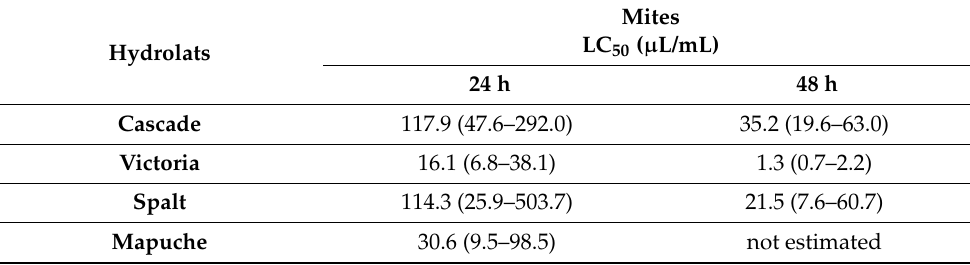
Table 3. Estimated LC 50 ( µ L/mL) values for Varroa destructor obtained at each time interval for each hydrolats from Humulus lupulus female flower cones of Mapuche, Cascade, Spalt, and Victoria